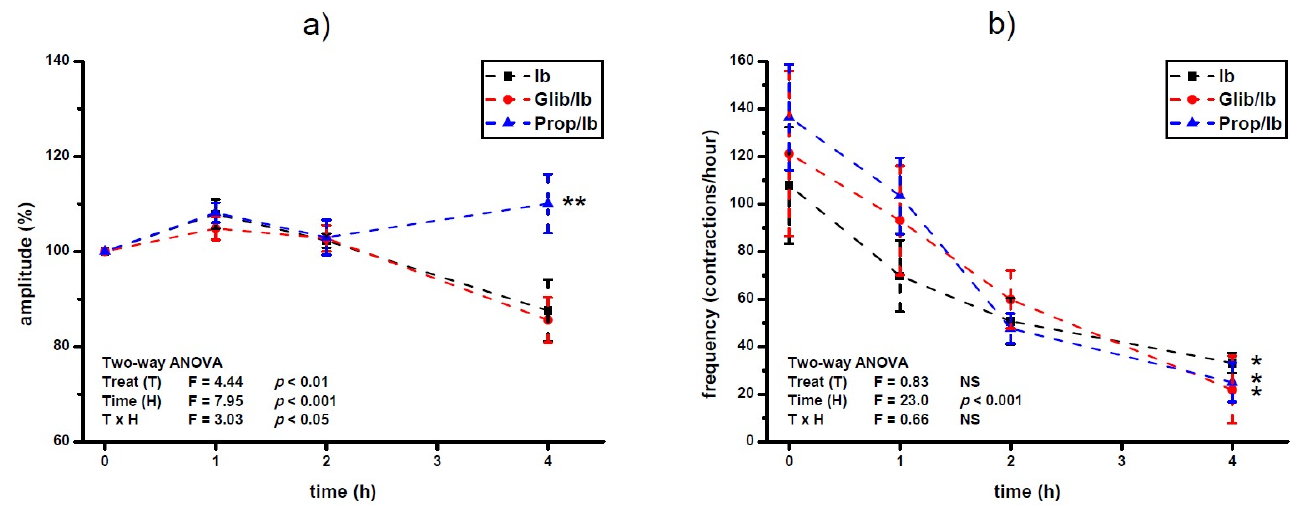
Figure 3. Amplitude ( a ) and frequency ( b ) of Ca 2+ -stimulated uterine contractions treated with a single dose of ibogaine (28.8 μ mol/L) and pre-treated with either glibenclamide or propranolol. Results are expressed as the mean ± SEM ( n =